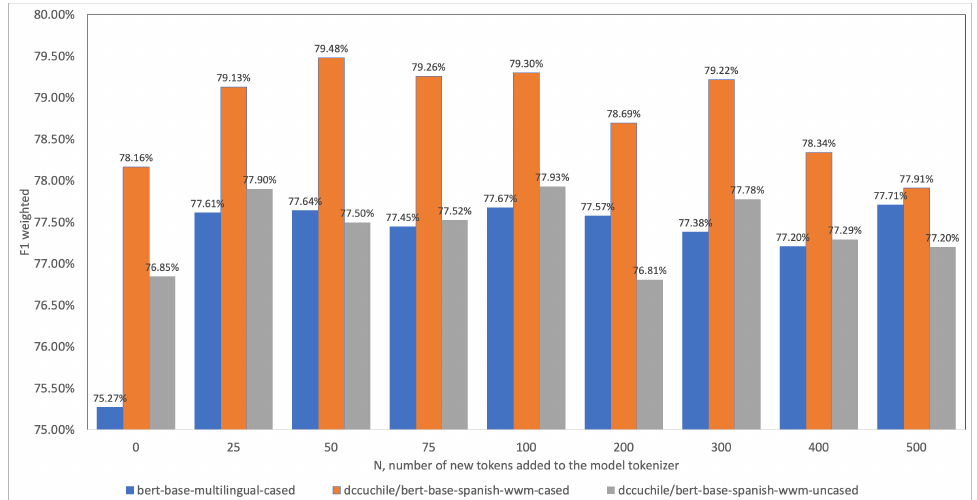
Figure 3. BERT models comparison when fine-tuning with our vocabulary extension